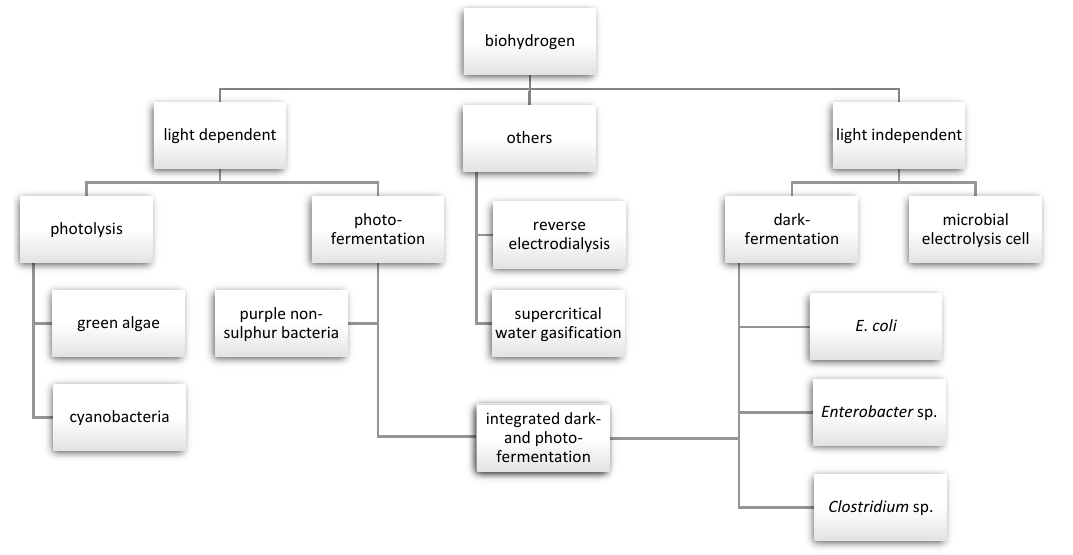
Figure 2. Methods of biological hydrogen